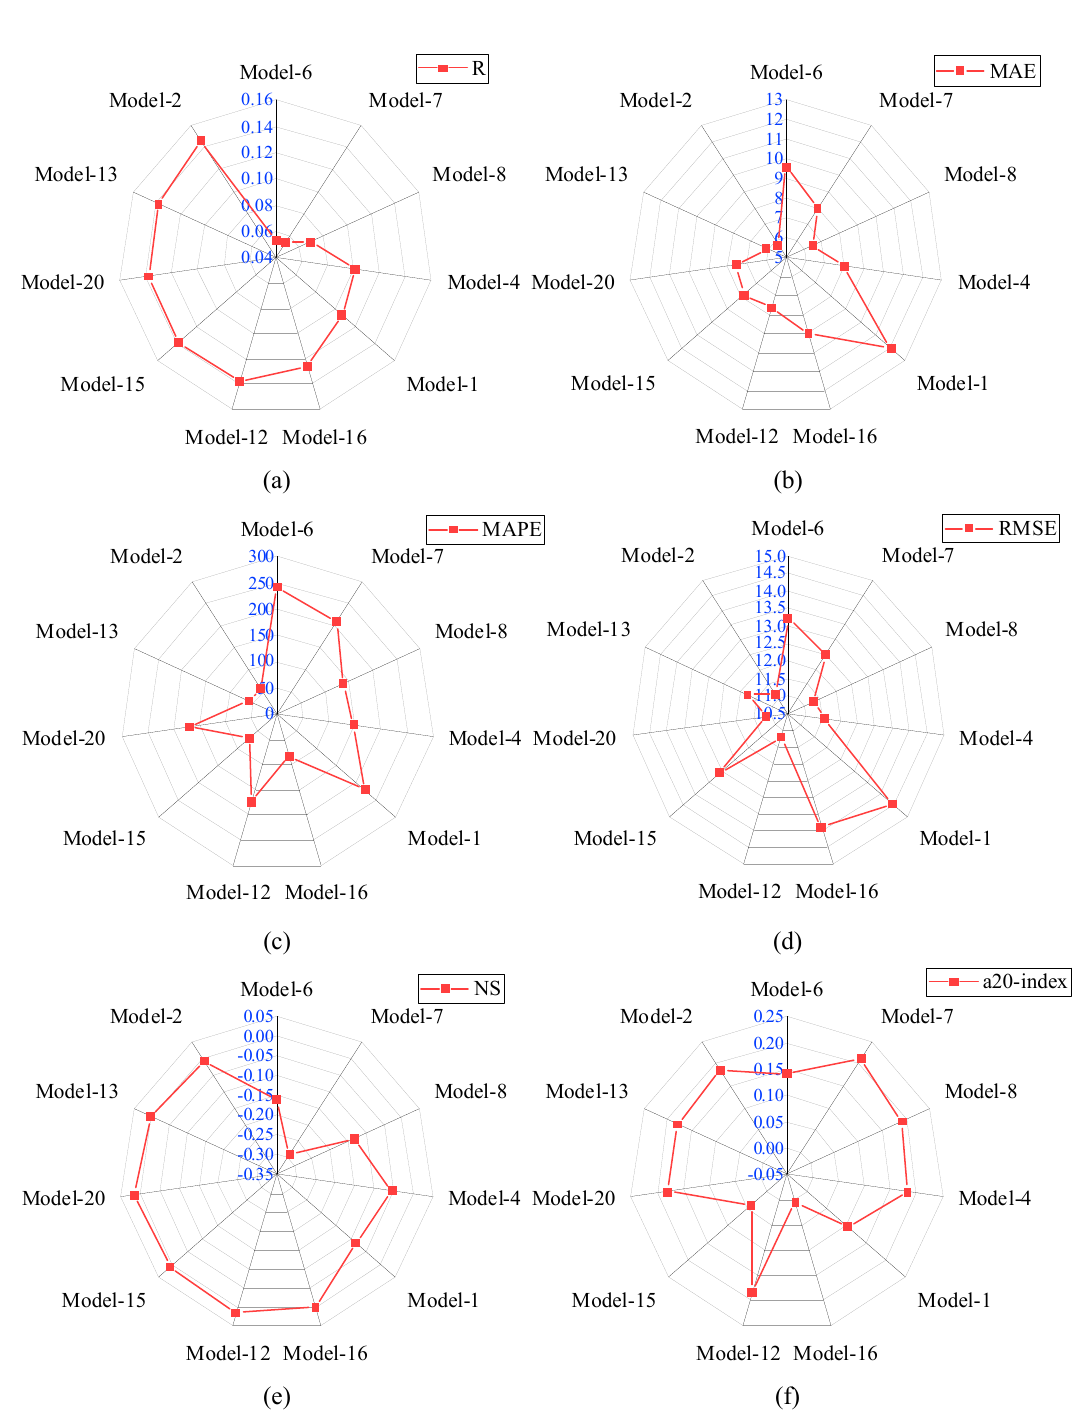
Figure 7. Comparison of performance indices of Group-I models; ( a ) R, ( b ) MAE, ( c ) MAPE, ( d ) RMSE, ( e ) NS, ( f ) a-20